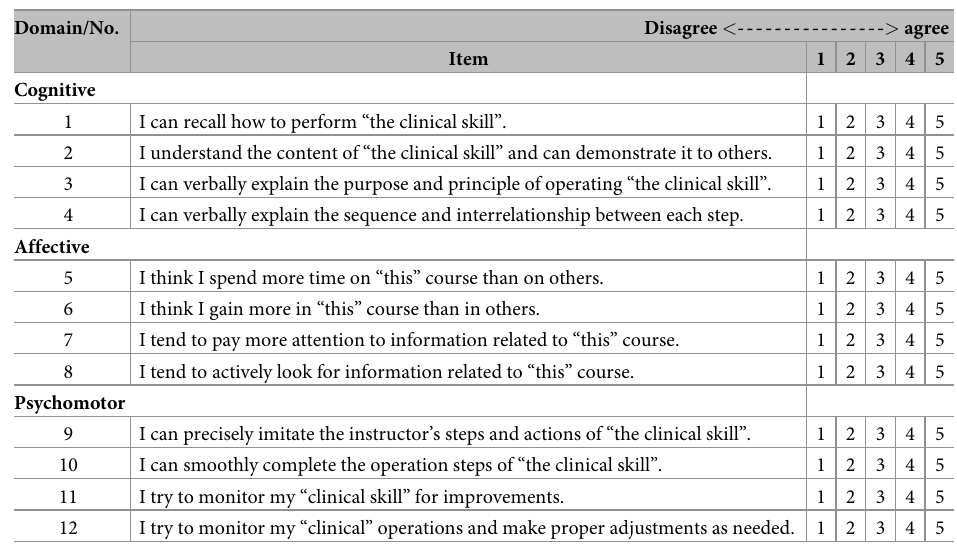
Users can replace the quoted phrases with target clinical